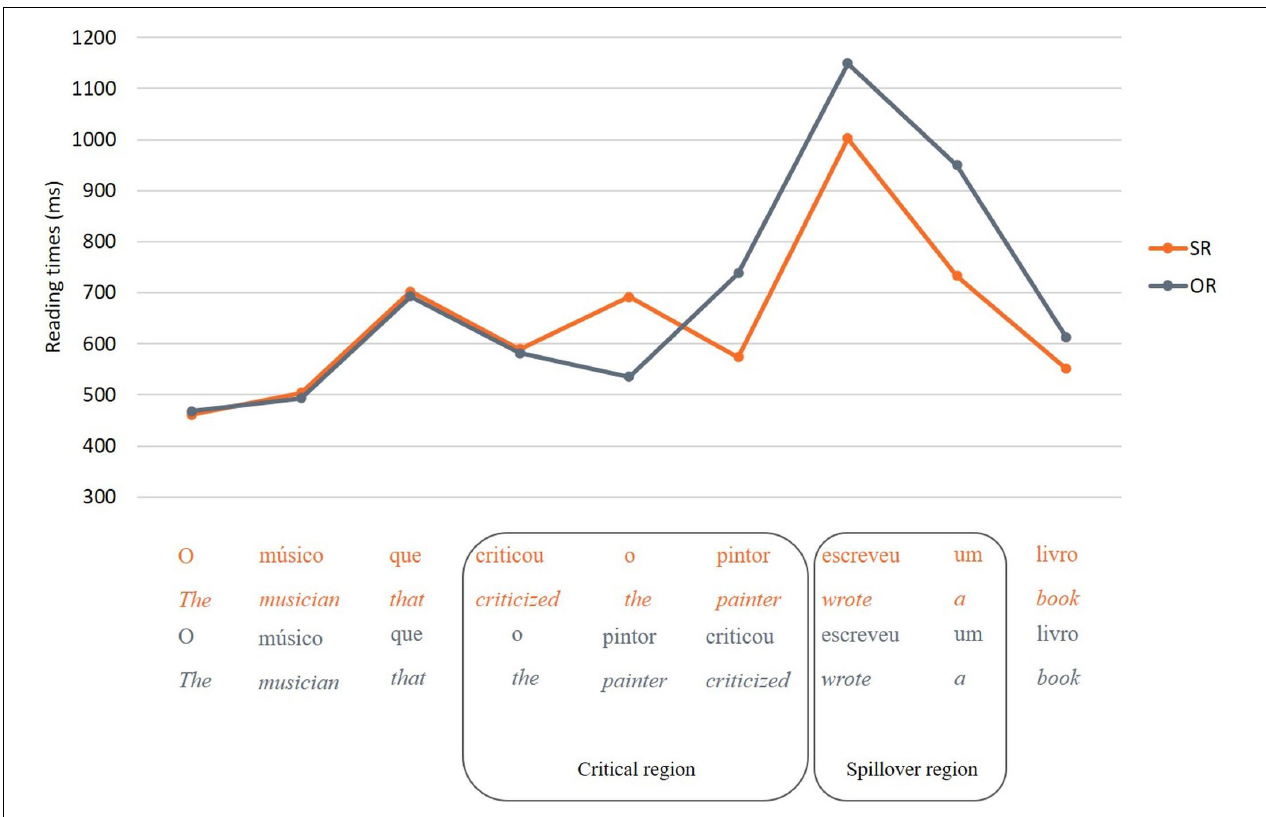
FIGURE 6 | Mean reading times per word for SR and OR